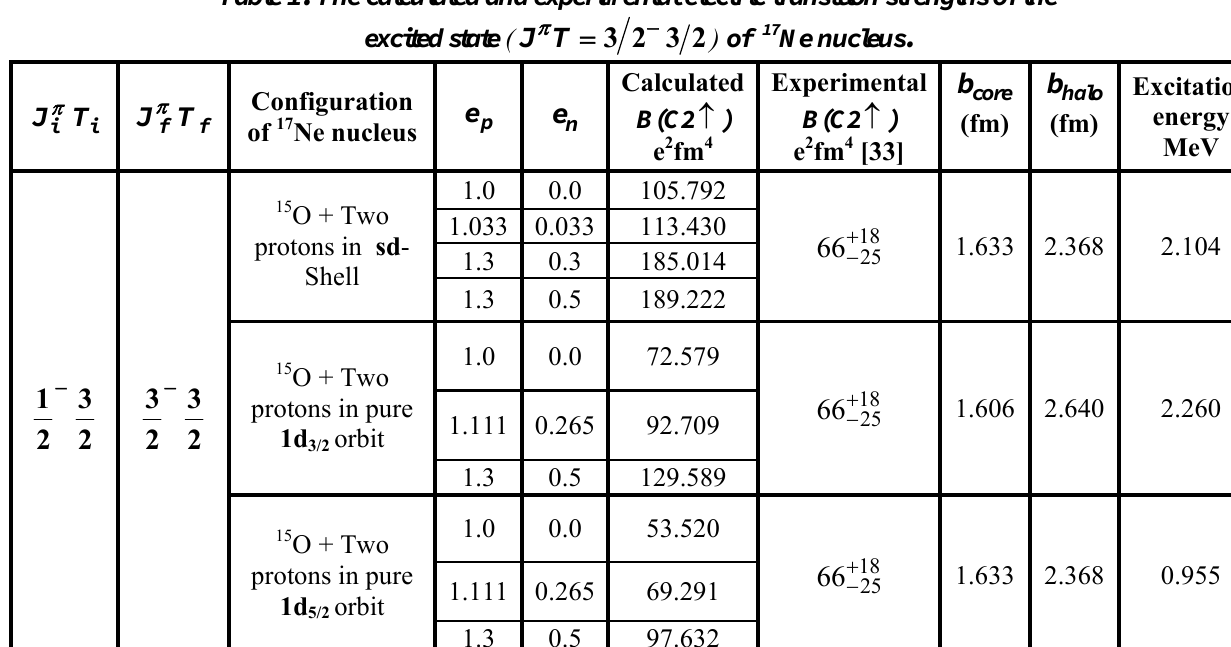
nucleon charges ( e =1.3 e , e =0.5 e). The p n dotted curve gives only one diffraction minimum located at ( q =1.34 fm -1 ), while the others gives two diffraction minima. There is a good conformation between all curves up to q  2.4 fm -1 , and the deviation between them is appear beyond this value. The calculated transition strength B(C2  ) values experimental value for any used charges as that shown in Table 2. In the case of the two protons are in a orbit (second configuration), the pure 1d 3/2 calculated C2 coulomb form factors for the